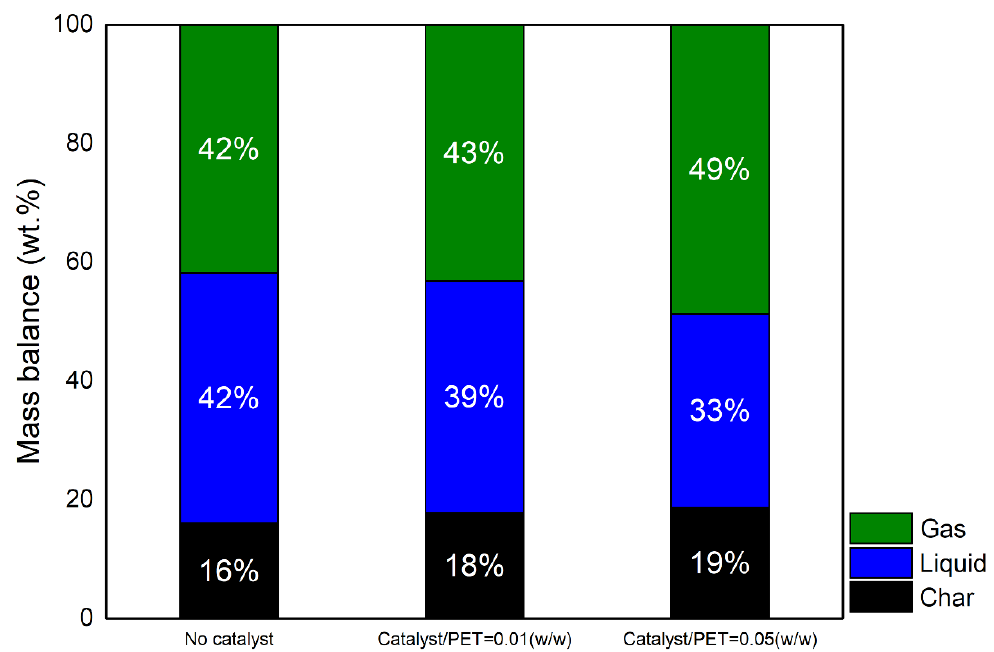
Figure 3. Comparing the mass balance of the pyrolysis of PET with a Pd catalyst and without a catalyst at 800 °C.